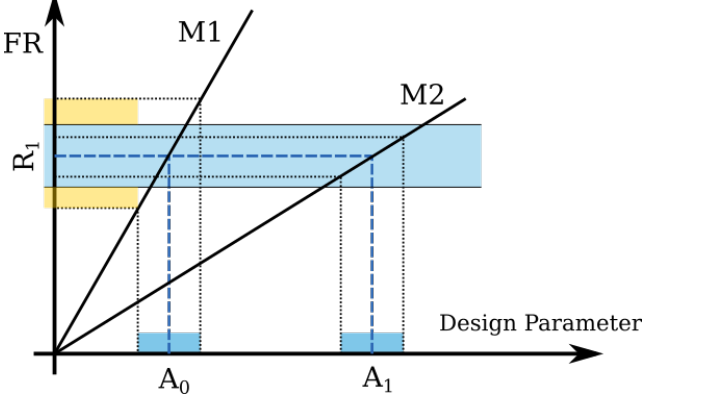
Figure 1. The tolerance on the required function parameter ( R 1 ) can be increased if a linear material property (M2) is changed by another one